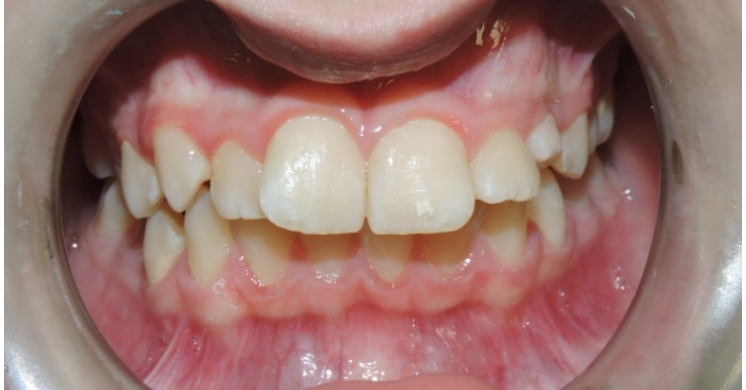
Methods Protoc. 2021 , 4 , x FOR PEER REVIEW Figure A1. Occlusion of patient B.R. Figure A1. Occlusion of patient B.R.